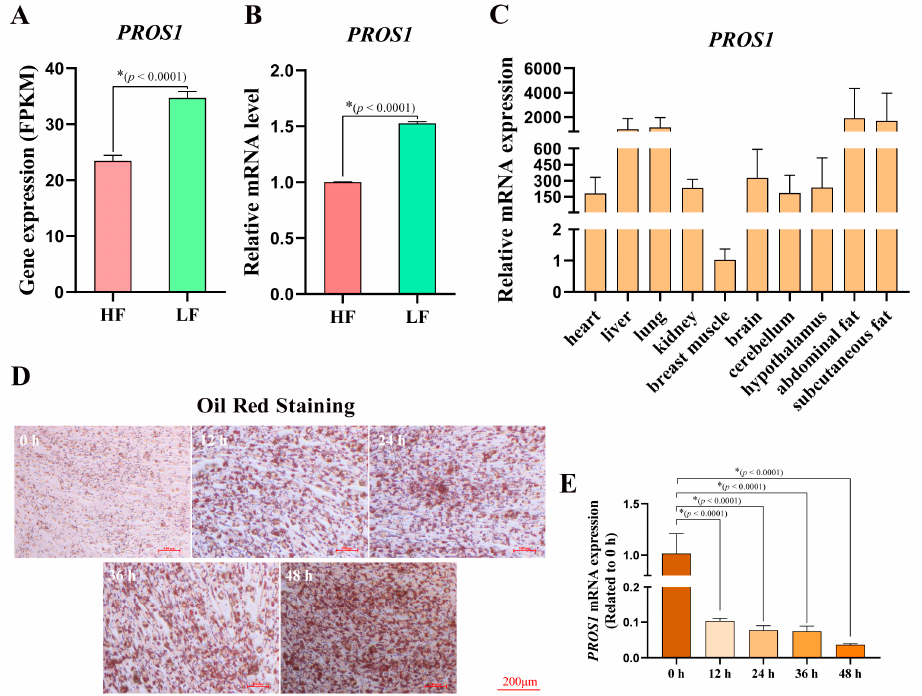
Figure 1. PROS1 was downregulated in high-fat chicken. ( A ) The gene expression difference of PROS1 in abdominal fat tissues between high-fat chicken and low-fat chicken shown in our previous RNA-seq. ( B ) The mRNA expression difference of PROS1 between high-fat chicken and low-fat chicken was detected by qRT-PCR. ( C ) PROS1 expression profile in different tissues. ( D ) The oil red O staining of ICP-1 cells treated with differentiation induction at different time points. ( E ) The PROS1 mRNA expression in ICP-1 cells treated with differentiation induction at different time points. The results are all presented as means ± SEM, * p < 0.05.